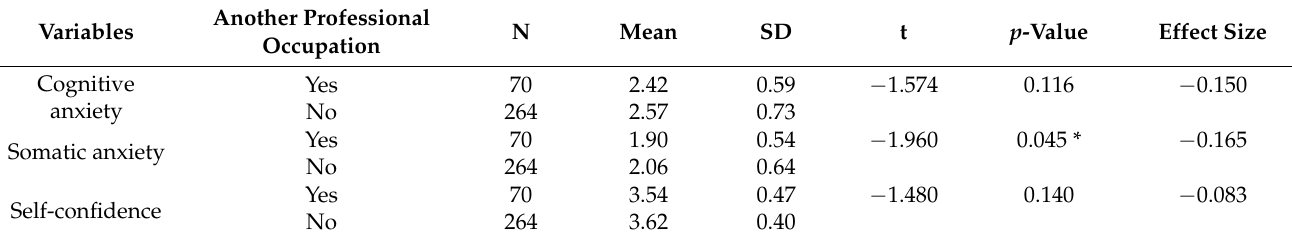
Table 7. Differences according to professional occupations.